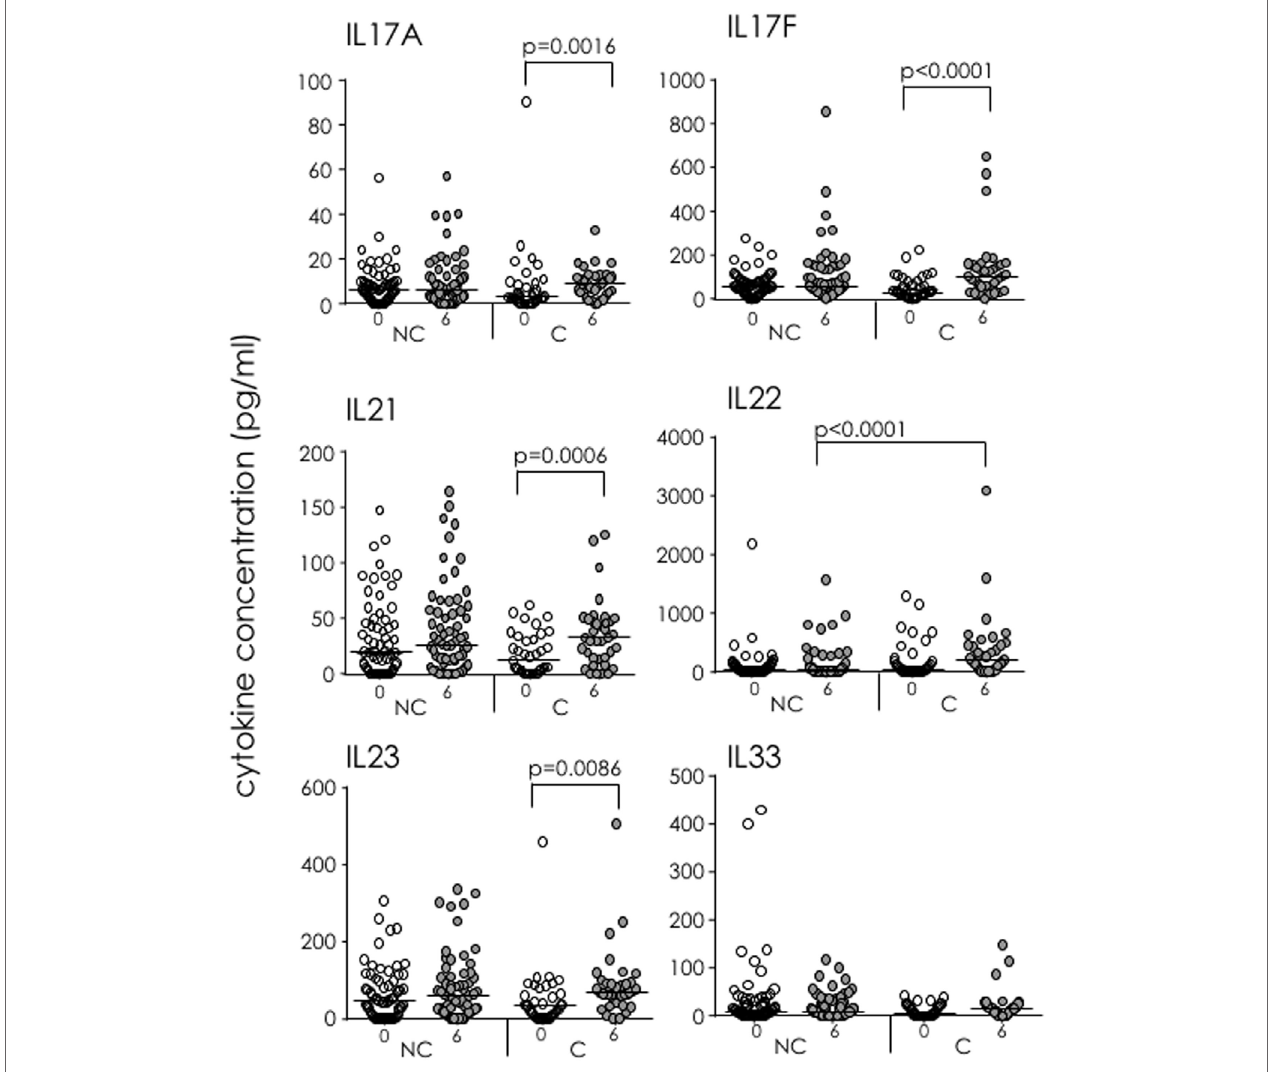
FigUre 5 | Soluble IL-17 superfamily factors in IFN- γ -release assay (IGRA) converters (C) and non-converters (NC) following purified protein derivative (PPD) stimulation of whole blood. 15-plex Th17 cytokine profiles were analyzed following PPD stimulation of whole blood from IGRA NC and C at recruitment (white dots) and 6 months (gray dots). Showing IL-17A, IL-17F, IL-21, IL-22, IL-23, and IL-33. Data were analyzed using Kruskal–Wallis test followed by Dunn’s post-test comparison. Bar indicates